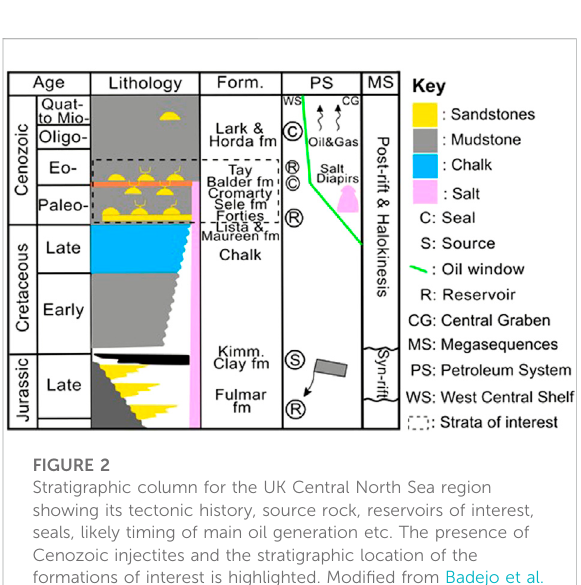
FIGURE 2 Stratigraphic column for the UK Central North Sea region showing its tectonic history, source rock, reservoirs of interest, seals, likely timing of main oil generation etc. The presence of Cenozoic injectites and the stratigraphic location of the formations of interest is highlighted. Modi fi ed from Badejo et al.